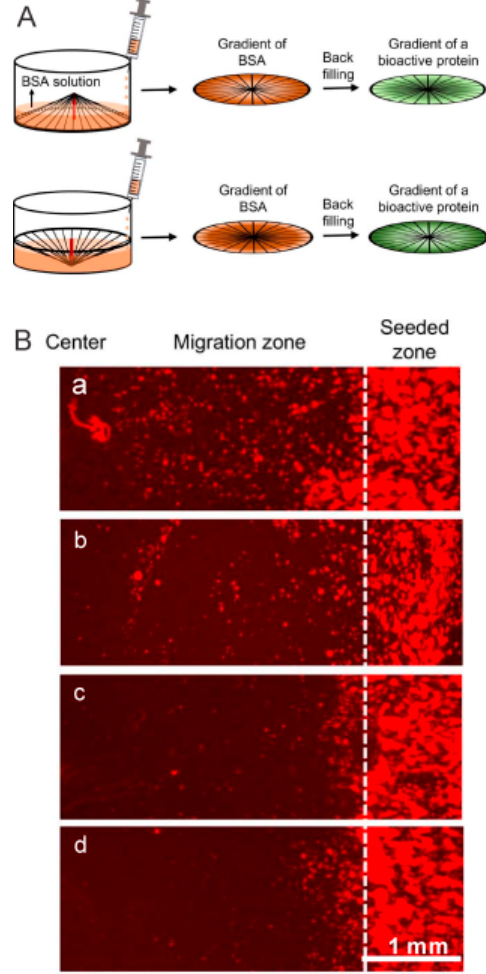
Figure 7. Circular gradients in electrospun nanofibers generated by the infusion method. ( A ) Schematic illustration of the infusion method to fabricate circular gradients. ( B ) EGF gradients on radially aligned nanofibers promoted migration of keratinocytes after 3 d of culture: ( a ) a graded coating of EGF, ( b ) a uniform coating of EGF, ( c ) a graded coating of BSA, and ( d ) bare scaffolds. Reprinted from References [55].